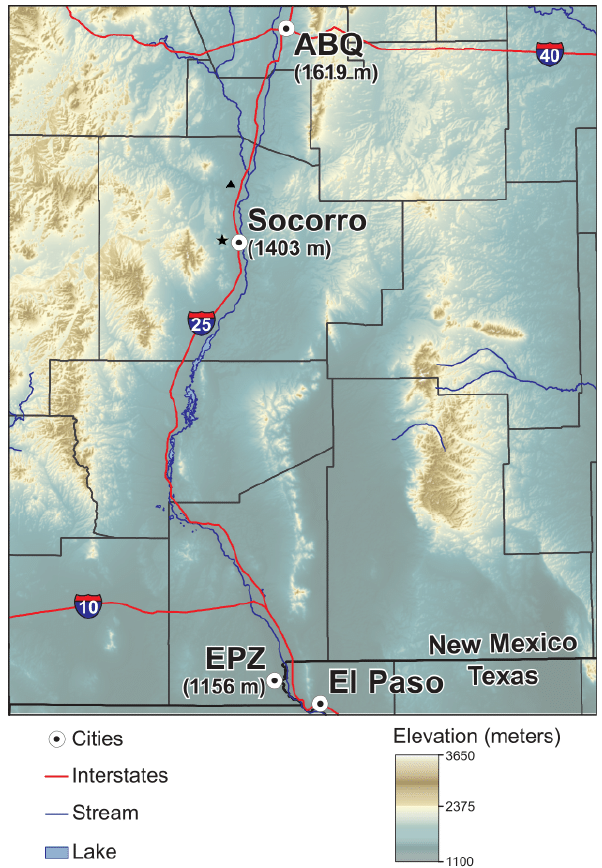
Figure 2. Topographical map of south-central New Mexico that shows the location of the measurement site at Socorro, along with the NWS radiosonde sites in Albuquerque (ABQ) and Santa Teresa (EPZ). The labels include surface elevations for all three locations. The black star and triangle indicate the locations of the Socorro SuomiNet and AERONET Sevilleta stations, respectively.